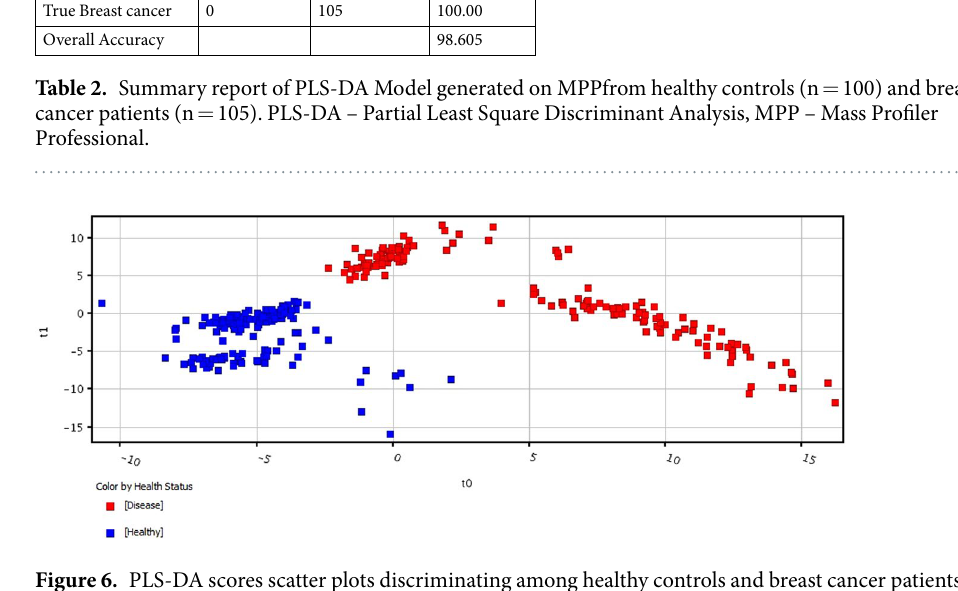
Figure 6. PLS-DA scores scatter plots discriminating among healthy controls and breast cancer patients based on seven significantly differentiated metabolite profiling data. The blue squares indicate healthy controls (n = 155) while the red squares denote Breast Cancer patients (n = 152) respectively. (PLS-DA: Partial Least Squares-Discriminant